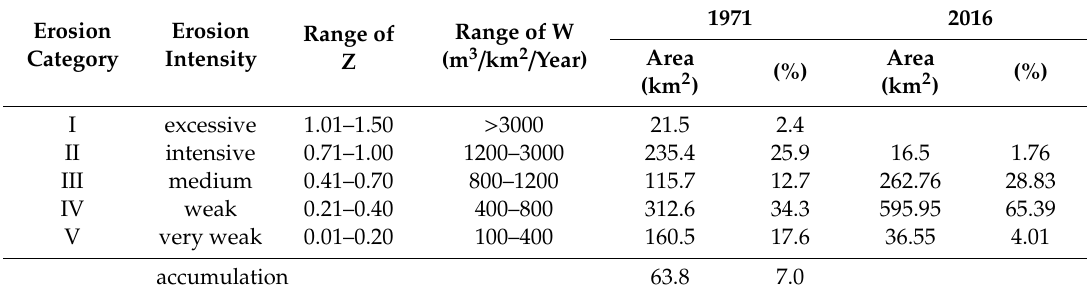
Table 2. Distribution of erosion processes in the basin (1971 and